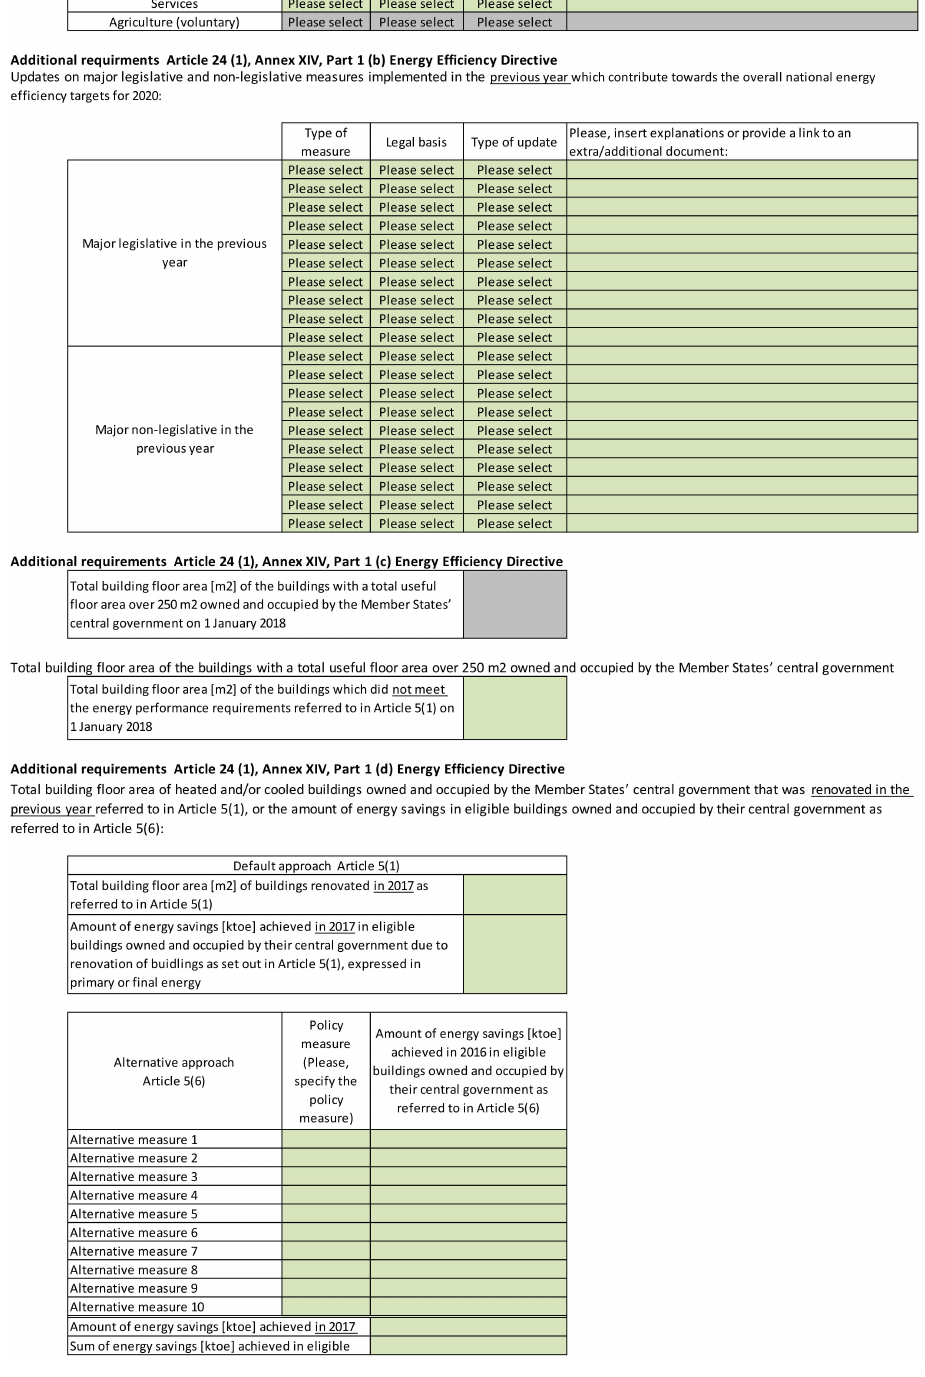
Figure A1. Common reporting template (part